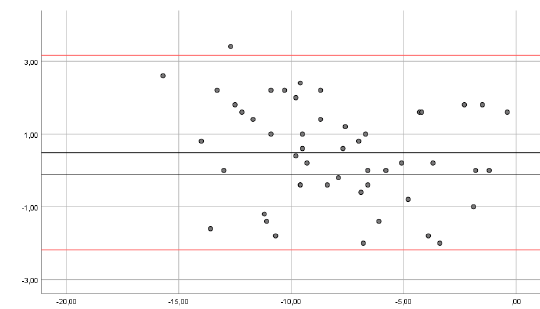
Figure 6. Bland–Altman plots comparing results between observers for the hip ankles ( a ), knee angles ( b ) and ankle angles ( c ). Bias (black line) and limits of agreement (red lines) are shown for each parameter. The mean score is plotted on the x -axis, and the difference between observers (mean of the differences) is plotted on the y -axis (mean difference ± 1.96 SD).